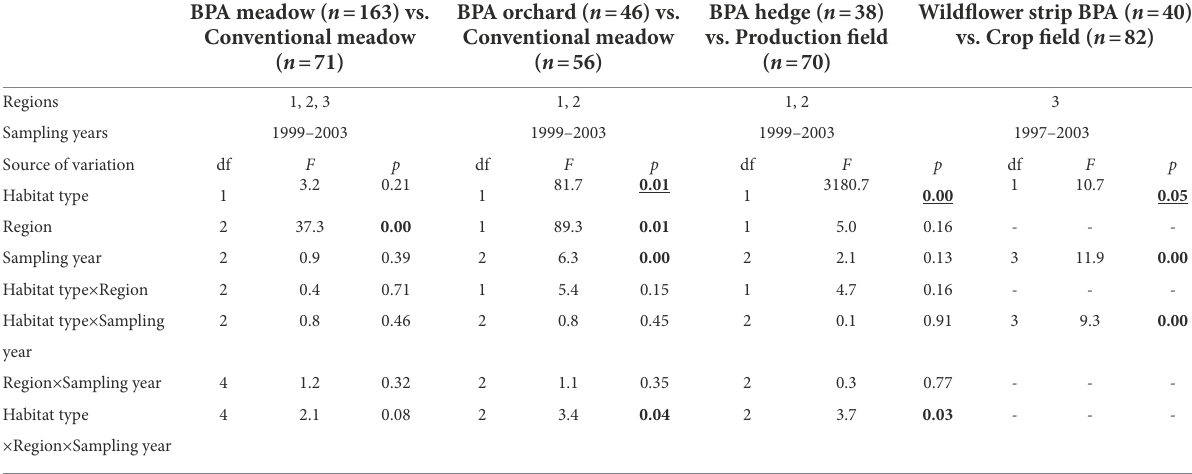
TABLE 1 Effects of habitat type (pairwise, BPA habitat types vs. conventionally managed fields), region and sampling year on alpha-diversity of spiders (rarefied at 100 individuals) in three regions of the Swiss plateau (mixed-model ANOVA with permutations). BPA meadow ( n = 163) vs. Conventional